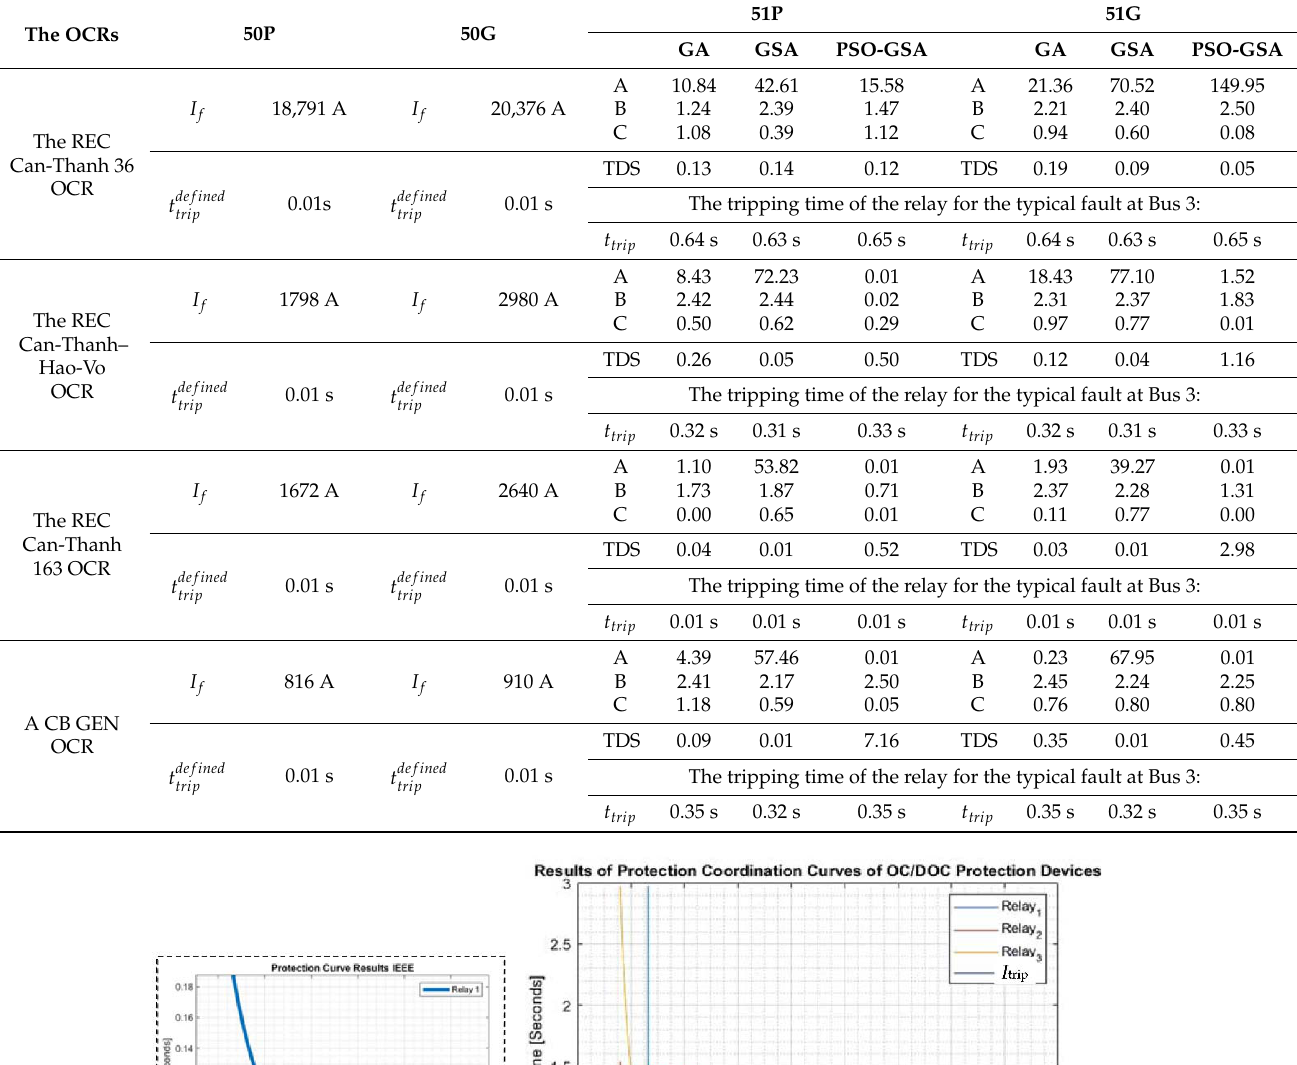
Table 7. Optimal protection coordination results of the OCRs in Scenario 4 and their tripping time when the fault is at Bus 3. The OCRs